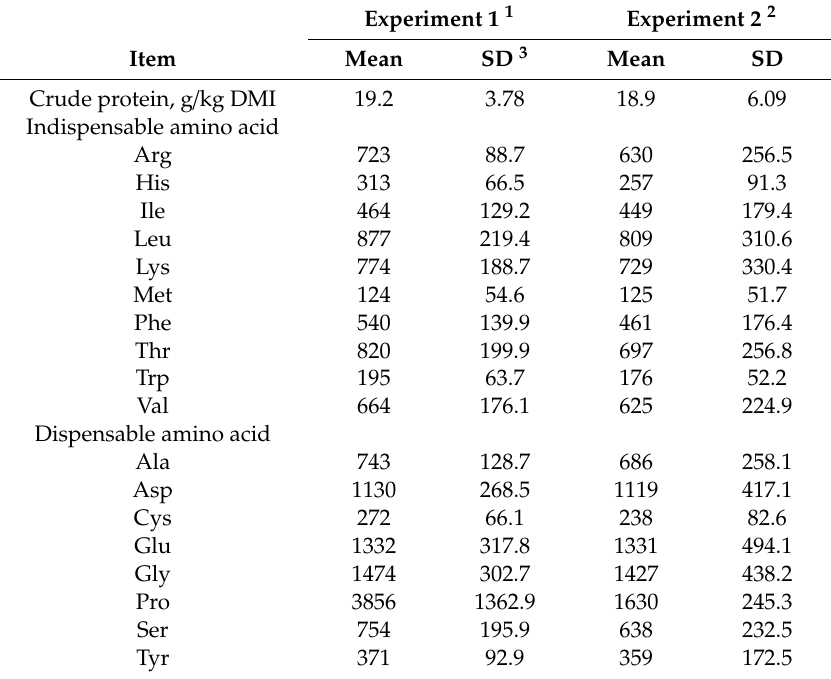
Table 4. Basal ileal endogenous losses of crude protein and amino acids (mg / kg of dry matter intake (DMI)) at the terminal ileum of pigs fed a nitrogen-free